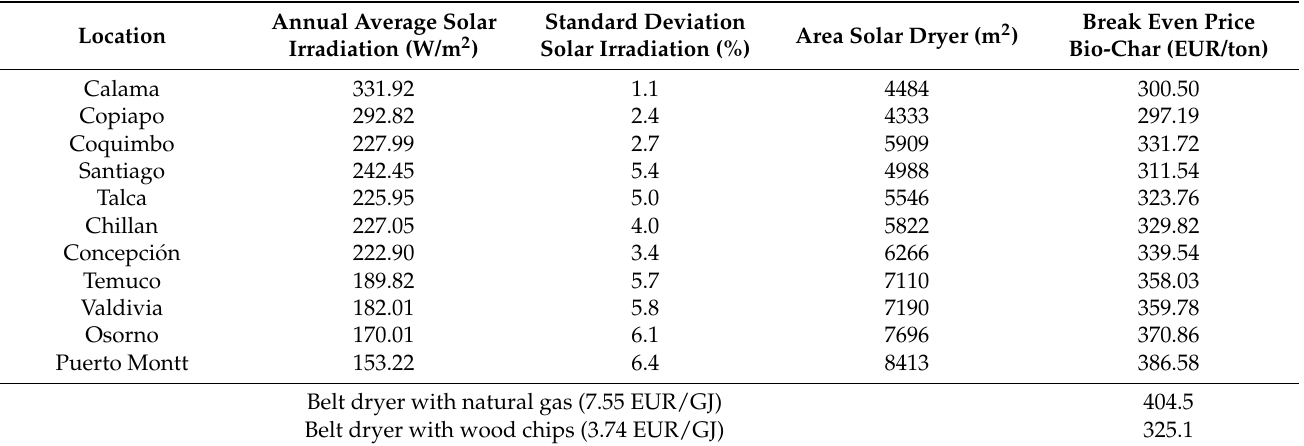
Figure 3. Locations and levels of solar irradiation. Table 5. Regional analysis of solar drying performance and bio-char